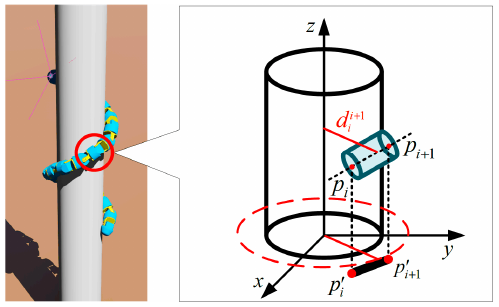
Figure 4. The single joint module in contact with the surface of a cylinder.